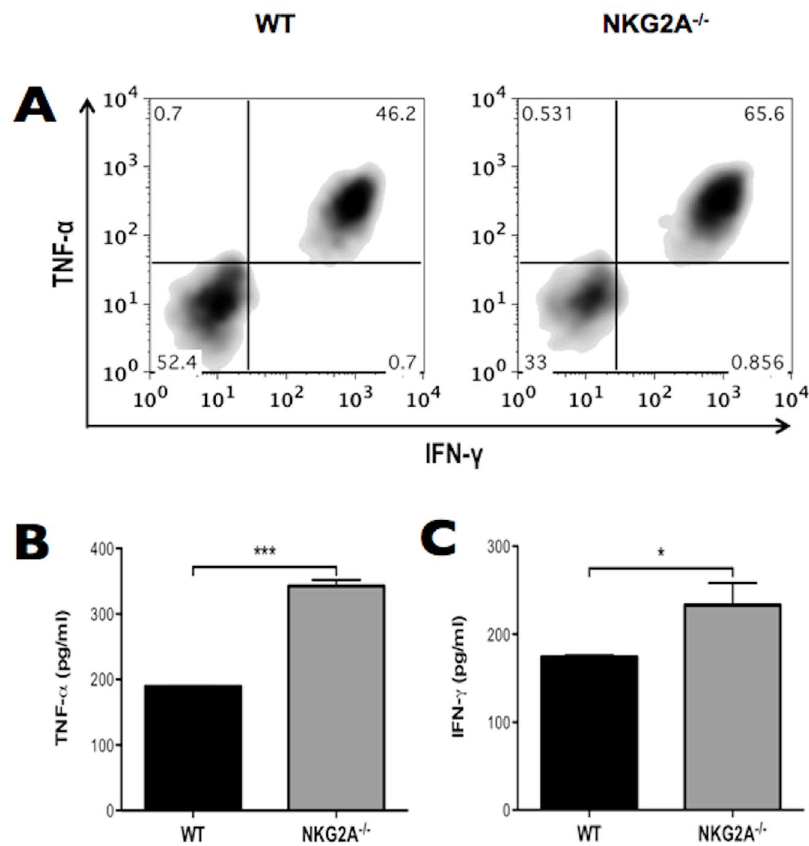
Figure 7. NP 366 -specific CD8 + T cells derived from NKG2A 2 / 2 mice have enhanced effector functions. (A) NP 366 -specific WT and NKG2A 2 / 2 CD8 + T cells were stimulated with NP 366 peptide in the presence of brefeldin A and total production of TNF- a and IFN- c was analyzed by FACS. Alternatively, ELISA was used to measure (B) TNF- a and (C) IFN- c production. Data are representative of at least two experiments with 3–5 mice. * p , 0.05 and *** p ,